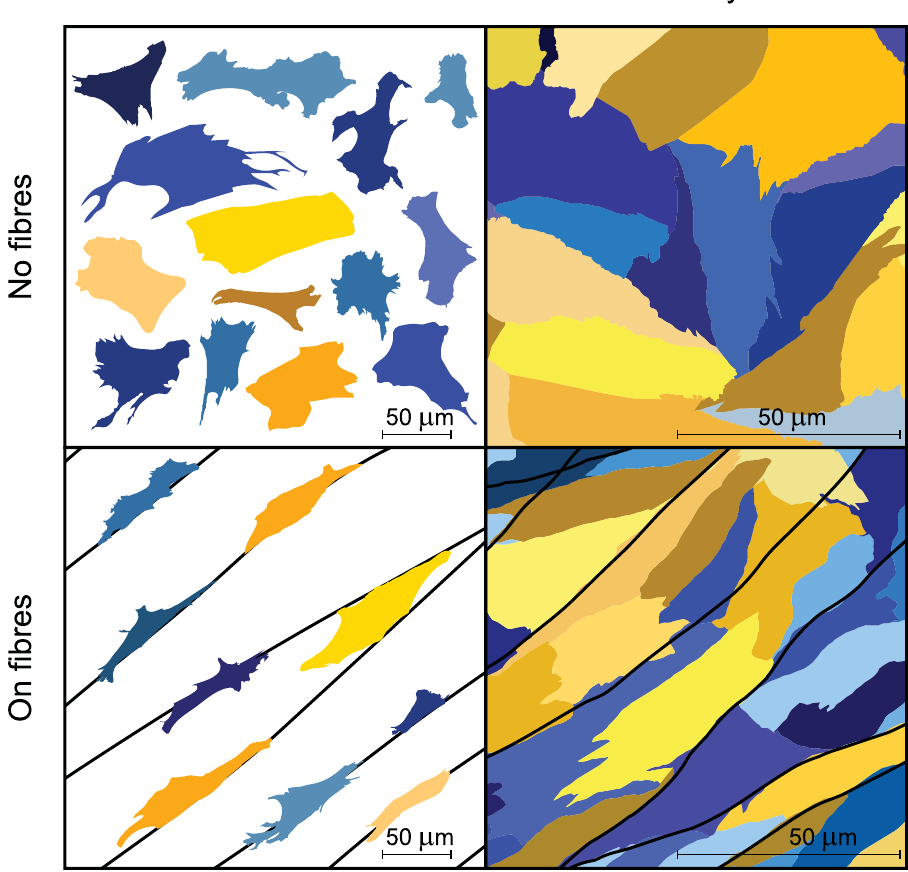
Figure 1. Experimental cases considered in our study. The first column shows isolated cells seeded at a low density to avoid cell–cell interaction. The second column represents cells in the monolayer. The substrate was isotropic in the upper row, whereas in the second row, nanofibres were added. Cardiomyocytes are shown in yellow tints, whereas fibroblasts are shown in blue tints. This image was based on immunohistochemical data but was refined for illustrative